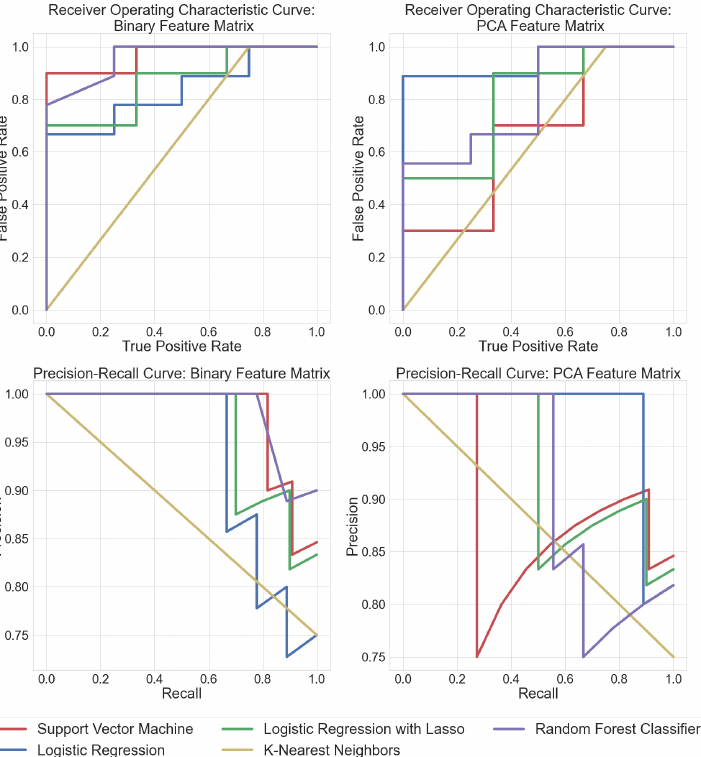
Figure 3. Receiver operating characteristic curves (ROC) depict the tradeoff between true positives vs. false positives for each algorithm (traces rising closer to the top left are better). The precision–recall curves (PRC) show the tradeoff between true positive vs precision in positive predictions for each algorithm (traces closer to the top right are better). This figure displays the ROC and PRC curves for classifiers trained on the binary feature matrix as well as the feature matrix after PCA, respectively. Table 1. Results of binary classification (bacteria vs. fungi) for the five supervised ML algorithms (averaged over 3-folds) on the binary feature matrix and the PCA-transformed data. The numbers in bold mark the highest values for each metric. It can be observed that decision tree classifiers trained on the binary feature matrix perform well, with highest overall accuracy, f-score, and